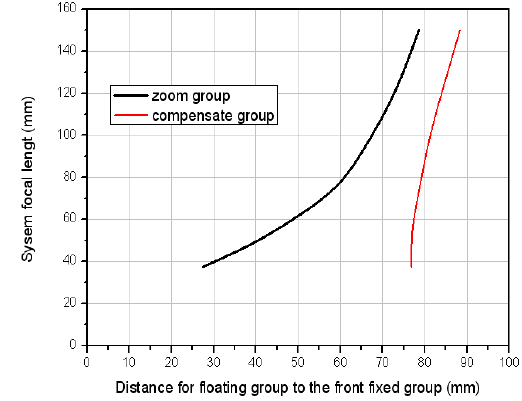
Fig.3 The zoom paths of the system 4.3